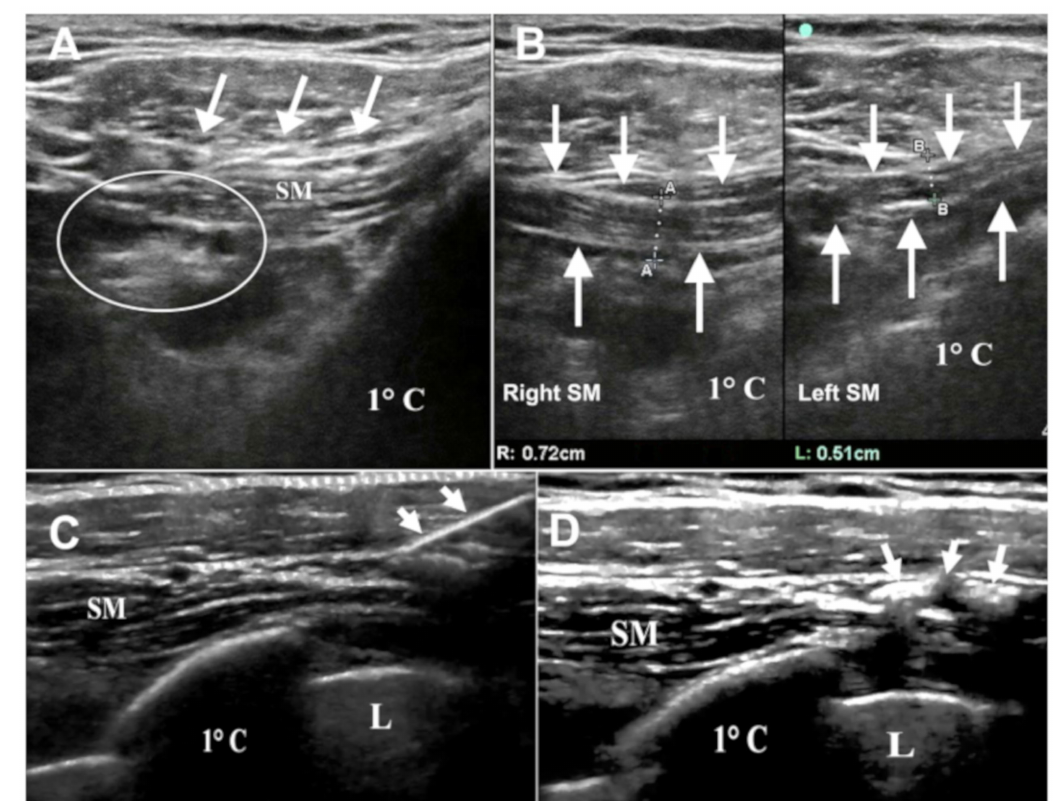
Figure 1. Brachial plexus echography performed with ultrasound transducer placed along the long axis of the Subclavius Muscle (SM). ( A ): the isolated hypertrophy of SM, which appeared fusiform (arrows), caused the compression of the lower part of the brachial plexus (circle). ( B ): comparing the left SM, that had a thickness of 0.51 cm, the right SM appeared hypertrophic and presented an increased thickness of 0.72 cm. ( C ): oblique insertion of the needle (arrows) within the SM belly. First rib (1 ◦ C), lung apex, and hyperechoic pleural line (L) were located below SM. ( D ): hyperechoic area secondary to BTX-A injection mixed with air bubbles (arrows). This mix allowed a better viewing of the toxin injected within the medial SM-tendon junction. First rib (1 ◦ C) and lung apex were located below